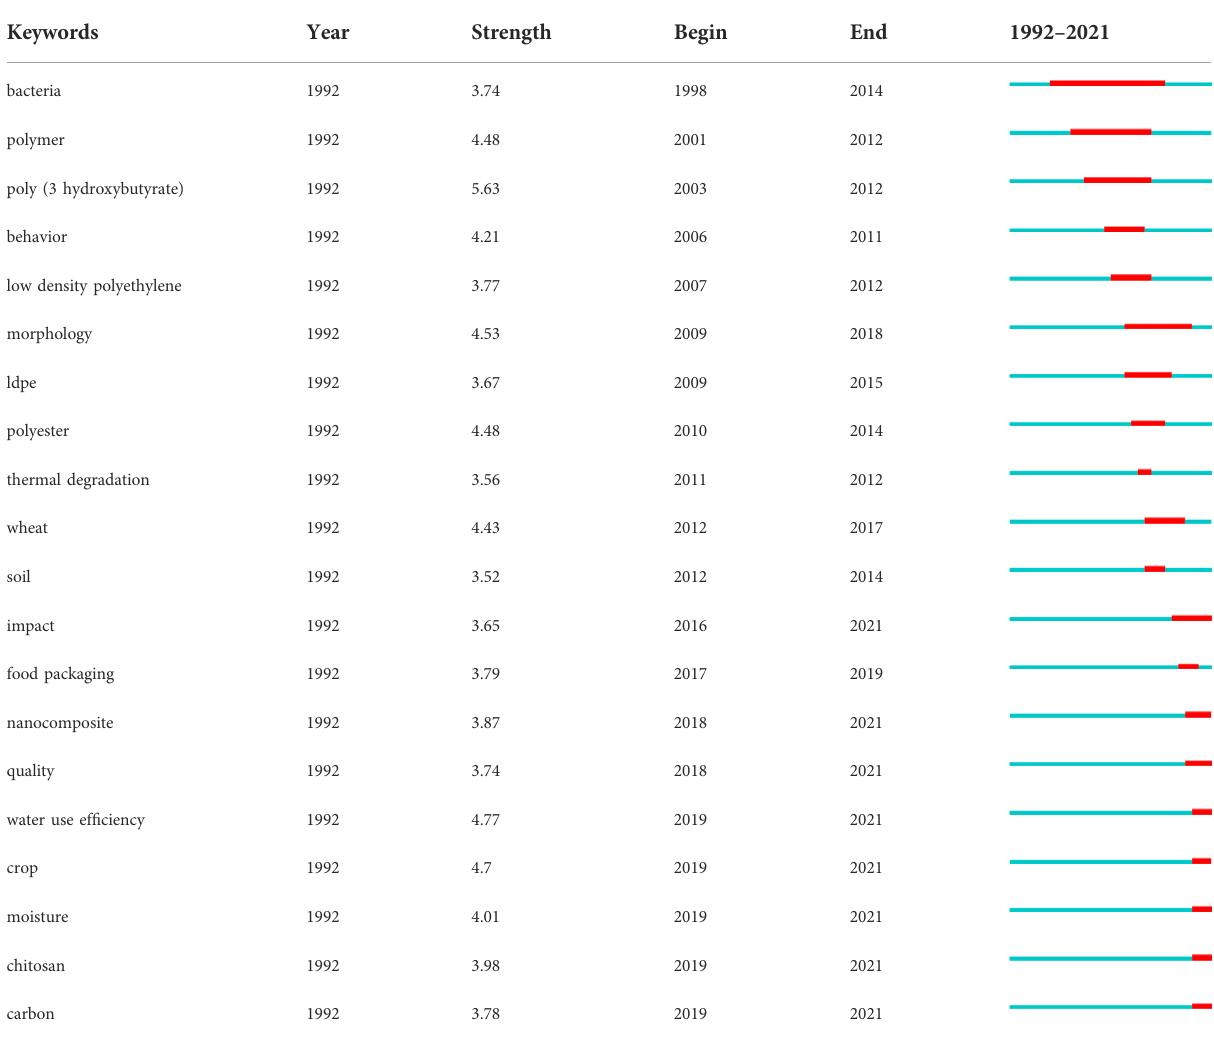
TABLE 7 Top 20 keywords with strongest citation